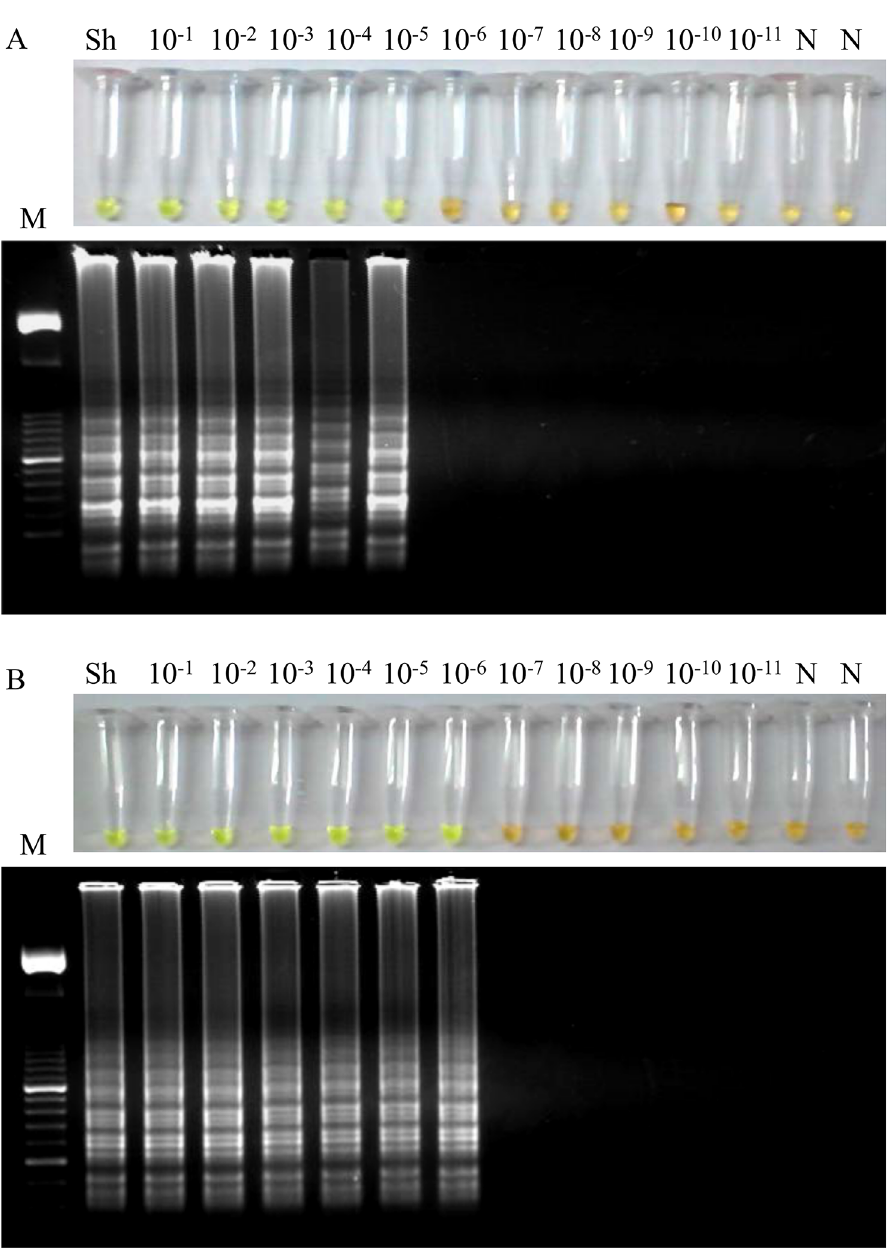
Fig 5. Examination of aliquots of whole urine from S . haematobium -positive patients´ urine samples by LAMP. Figure shows the LAMP results (up, by color change; down, by agarose electrophoresis) when using aliquots of 100 μ L of whole urine to obtain DNA as template by using (A) the i-genomic Urine DNA Extraction Mini Kit (Intron Biotechnology, UK); (B) the heating NaOH-SDS method and (C) the rapid heating method. Lanes M: 50 bp DNA ladder (Molecular weight marker XIII, Roche); lanes Sh: genomic DNA from S . haematobium (1 ng); lanes 1 – 18: S . haematobium -positive samples; lanes N: negative controls (no DNA